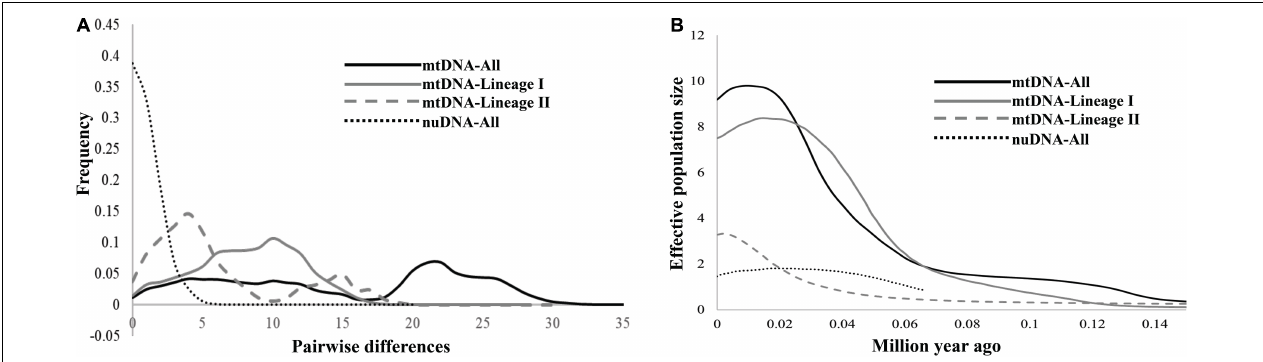
FIGURE 6 | (A) The mismatch distributions for all samples based on mtDNA and nuDNA, and for mtDNA lineages I and II, respectively. (B) Bayesian skyline plots of all samples based on mtDNA and nuDNA, and for mtDNA lineages I and II, respectively. The y-axis is the product of the effective population size (Ne) and the generation length on a log scale, while the x-axis is the time scale before the present in units of a million years ago.